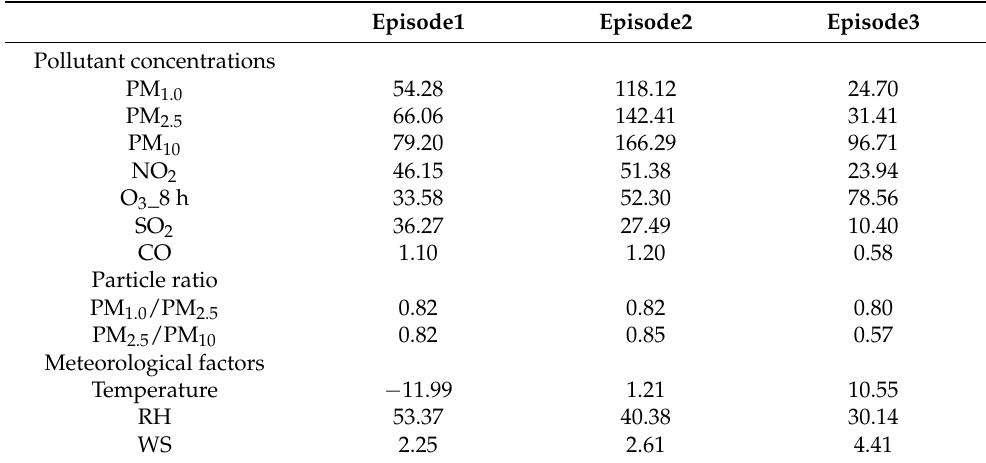
Table 2. Hourly average concentrations of pollutants and meteorological factors in Ep1, Ep2 and Ep3. The unit for CO is mg/m 3 , while that of remaining pollutants is µ g/m 3 ; the units of wind speed, relative humidity and temperature are m/s, % and ◦ C,